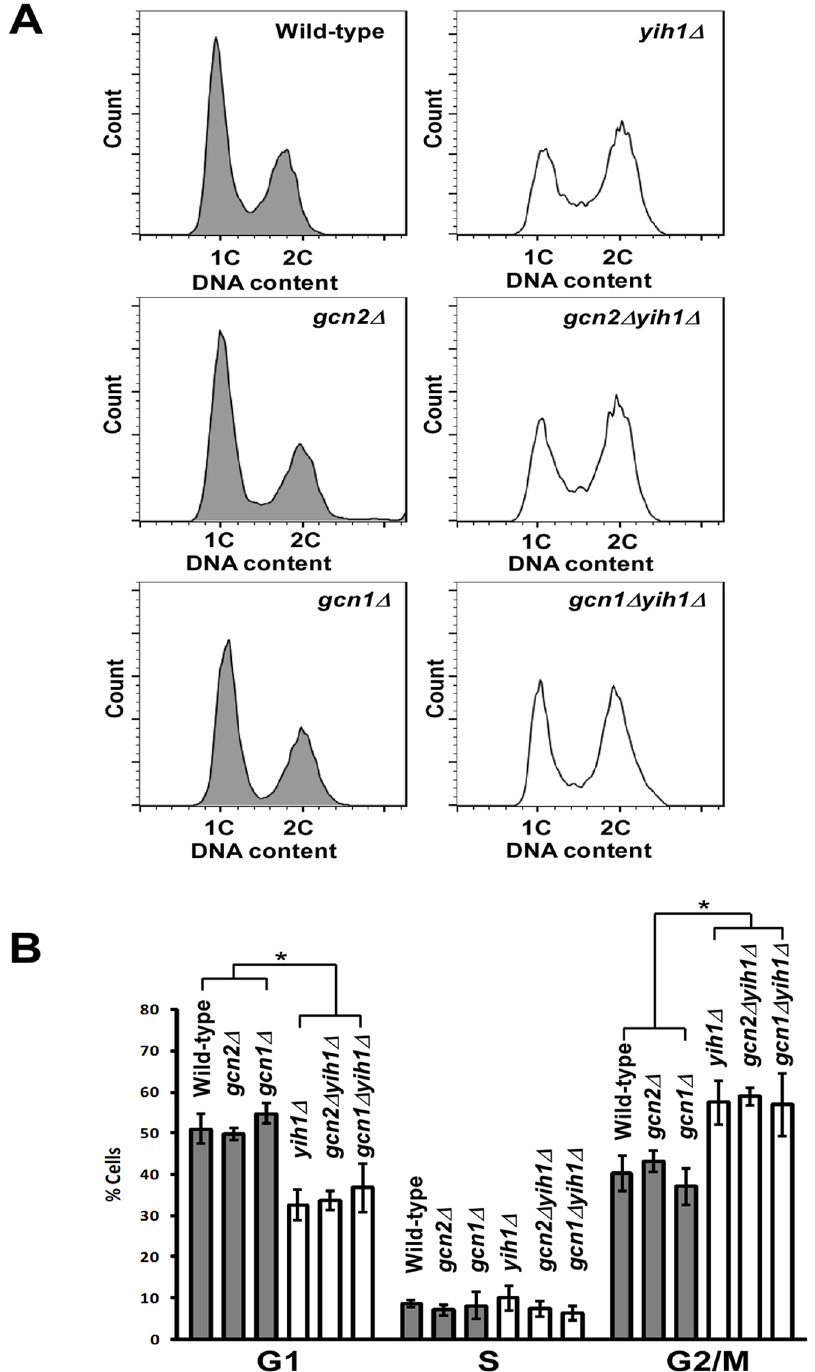
Fig 5. The abnormal cell cycle phenotype of yih1 Δ cells does not depend on Gcn2 or Gcn1. (A) Representative histograms of DNA content of asynchronous cultures: wild type (H1511), and yih1 Δ (ESY11001b), gcn2 Δ (H2557) and gcn1 Δ (H2556) single mutants, and yih1 Δ ;gcn2 Δ (ESY10075aa) or yih1 Δ ; gcn1 Δ (ESY10075aa) double mutants, grown to log-phase in YPD, stained with PI and analyzed by flow cytometry; the distribution of cells in G1 (1C), S or G2/M (2C) is shown. (B) The proportion of cells in G1 (1C), S or G2/M (2C), as determined from (A) is given as percentage of the total cell number, quantified using the flow cytometry gates depicted in A with the cell-cycle tool (Watson model) of Flowjo software, 9.3.3 version. Data are presented as means ± S.E. ( error bars ) of three independent experiments. * p < 0.05